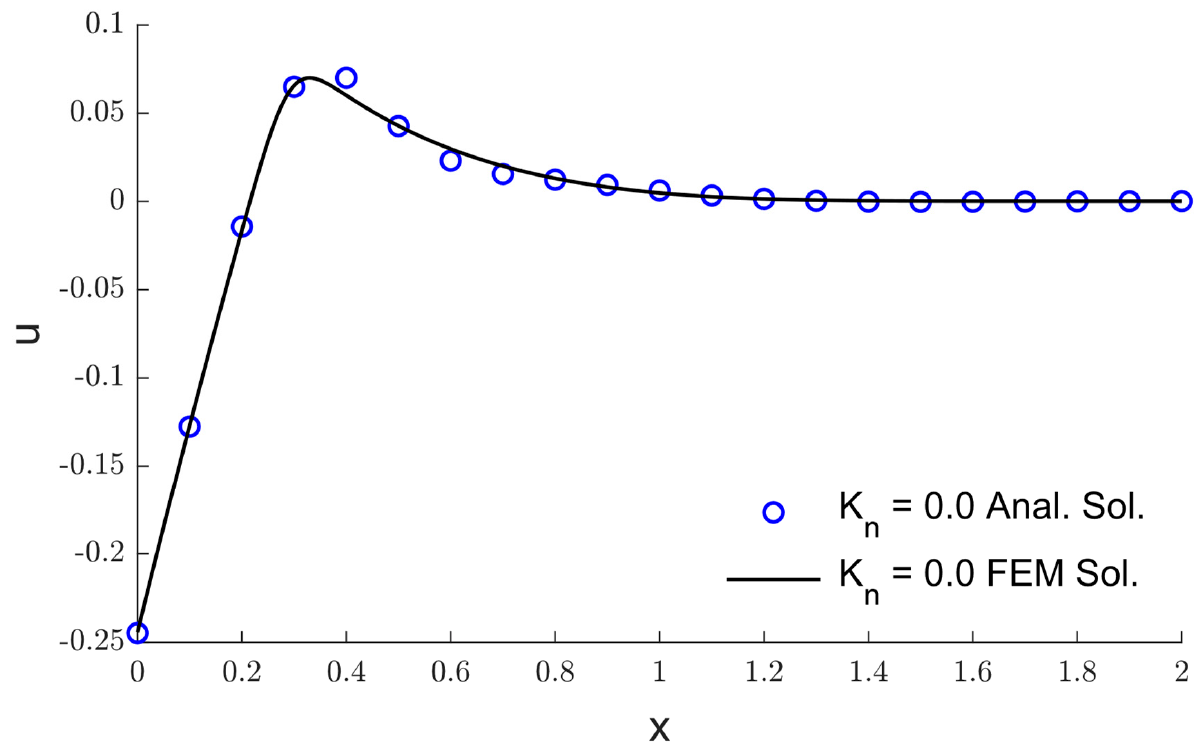
= 𝜏 = 0.05 and 𝐾 = 0 , (cid:3042) (cid:2869) (cid:3041)